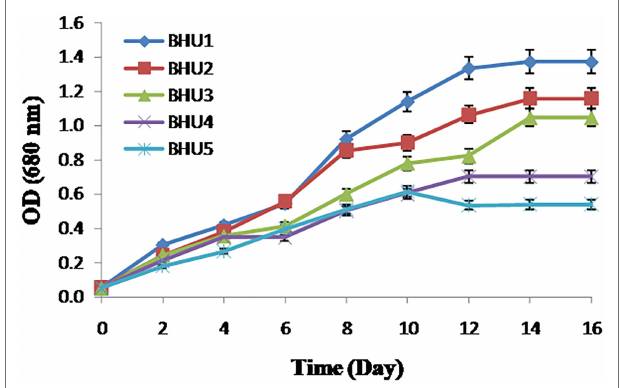
FIGURE 1 | Growth measurement in terms of optical density of different algal strains grown in BG − 11 N + medium supplemented with 12 mM NaHCO 3 . The data represents mean ± SE ( n =